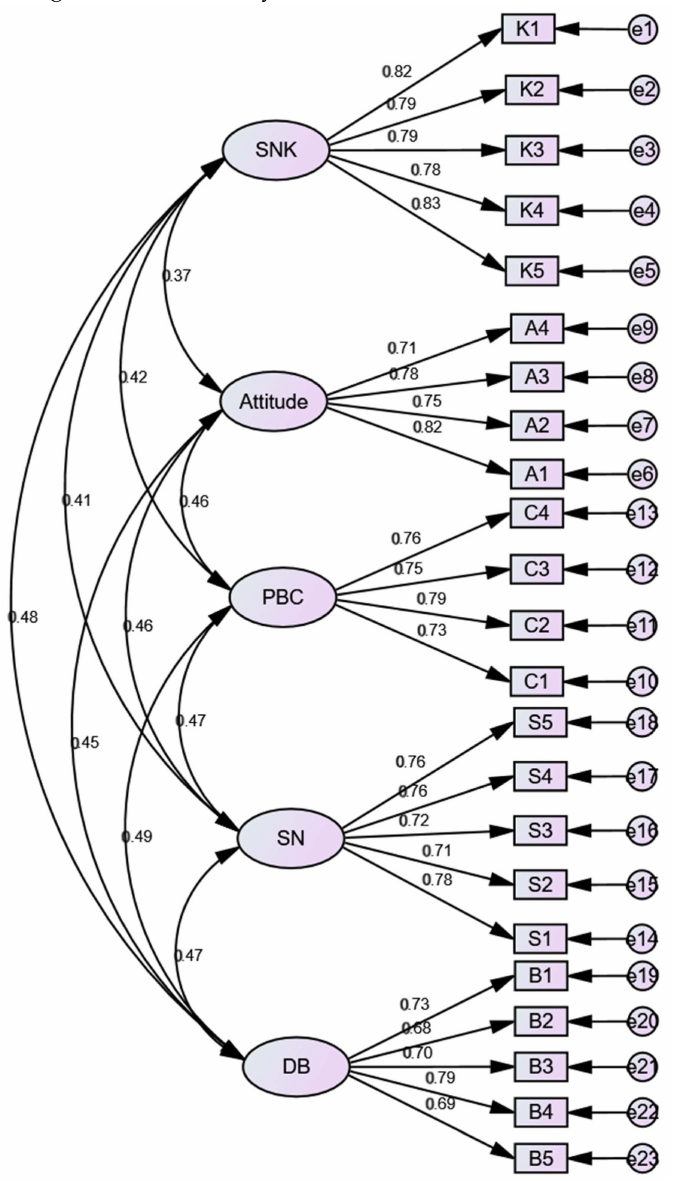
Figure 1. Standardized estimation of knowledge, attitude, and behavior